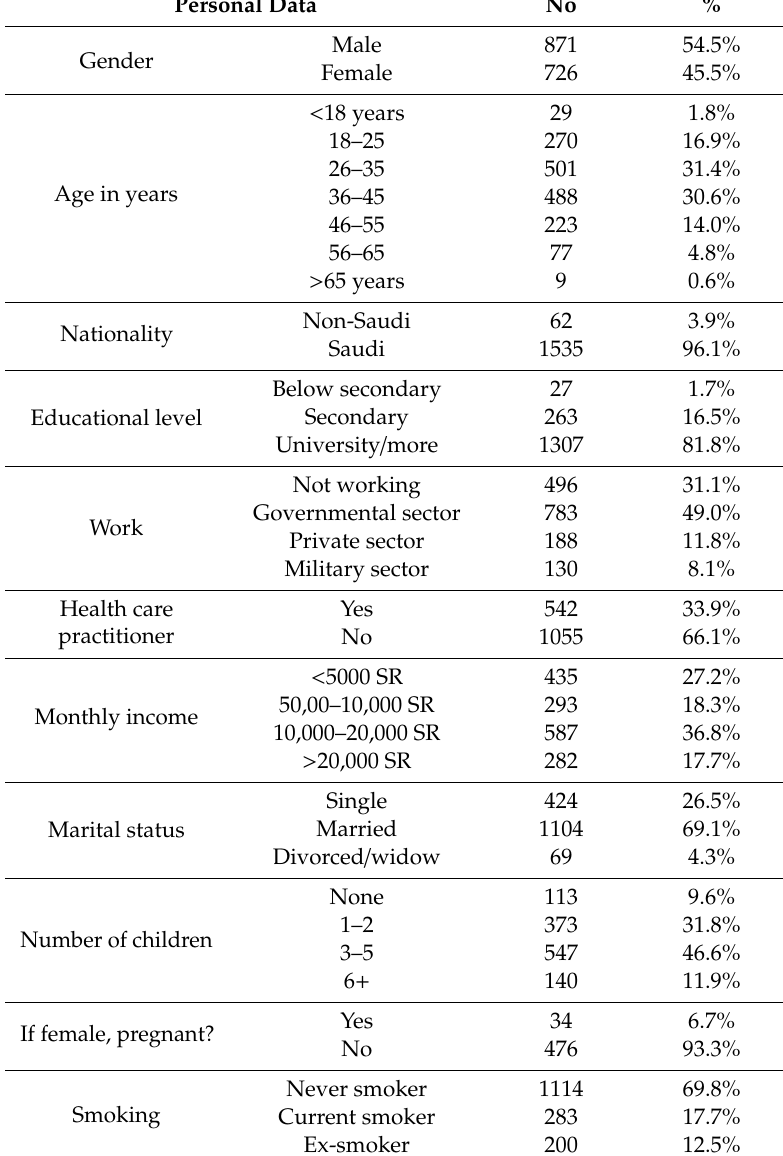
Table 2. Personal data of survey participants regarding psychological impact of COVID-19 on public, Saudi Arabia,